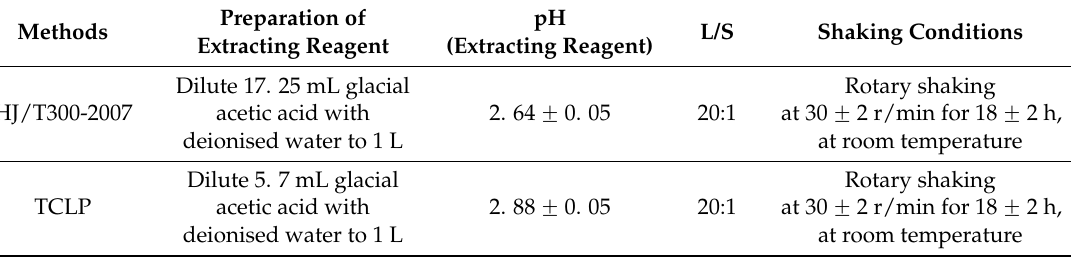
Table 1. A comparison of HJ/T300-2007 and TCLP.